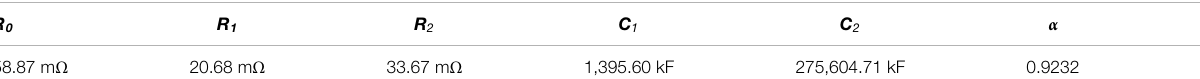
TABLE 2 | Model parameter identi fi cation results.